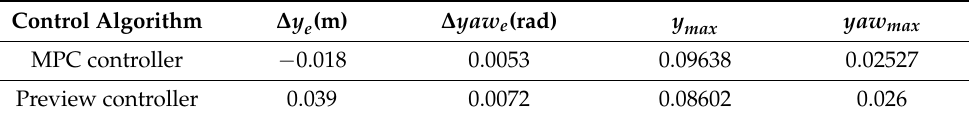
Table 4. Parking position error.